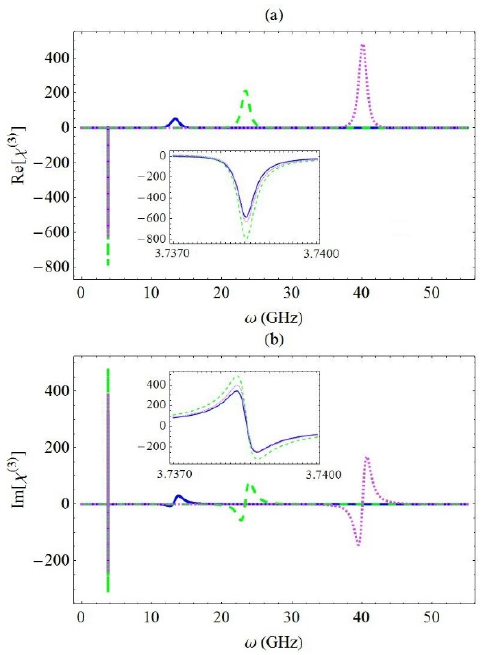
Finally, in Figure 6, the real part (a) and the imaginary part (b) of the third-order optical susceptibility (3) χ are presented for different values of the exciton resonance fre- quency. More specifically, the blue solid curve corresponds to green dashed curve and the magenta dotted curve correspond to 10 GHz and 15 GHz